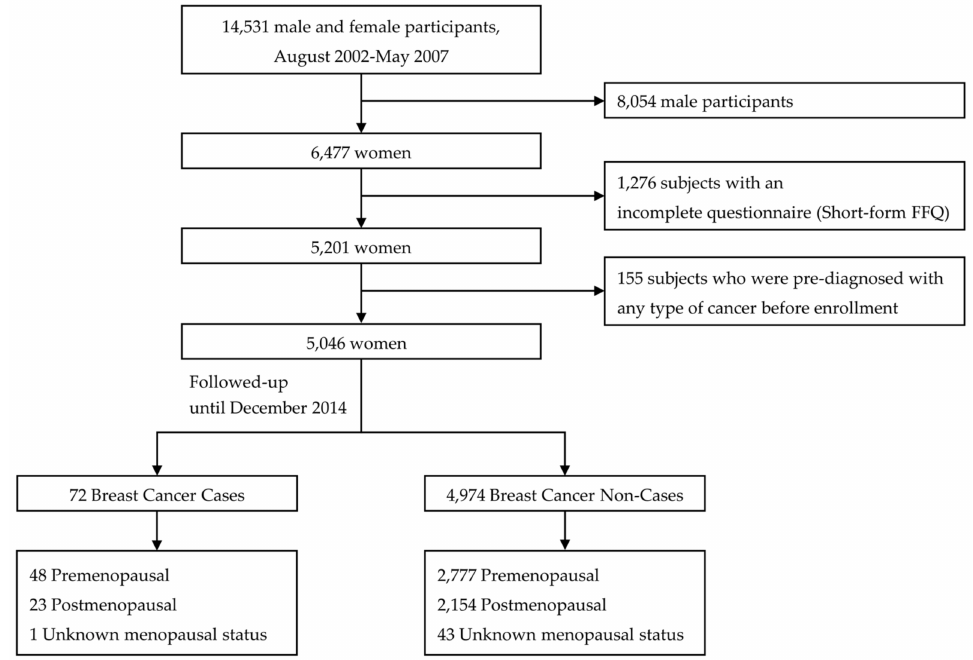
Figure 1. Flow chart of the study